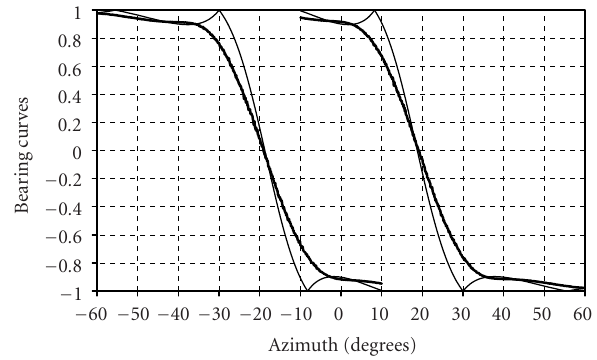
Figure 7: The rms of bearing estimation error for various SNRs and for the number of scatterers N =